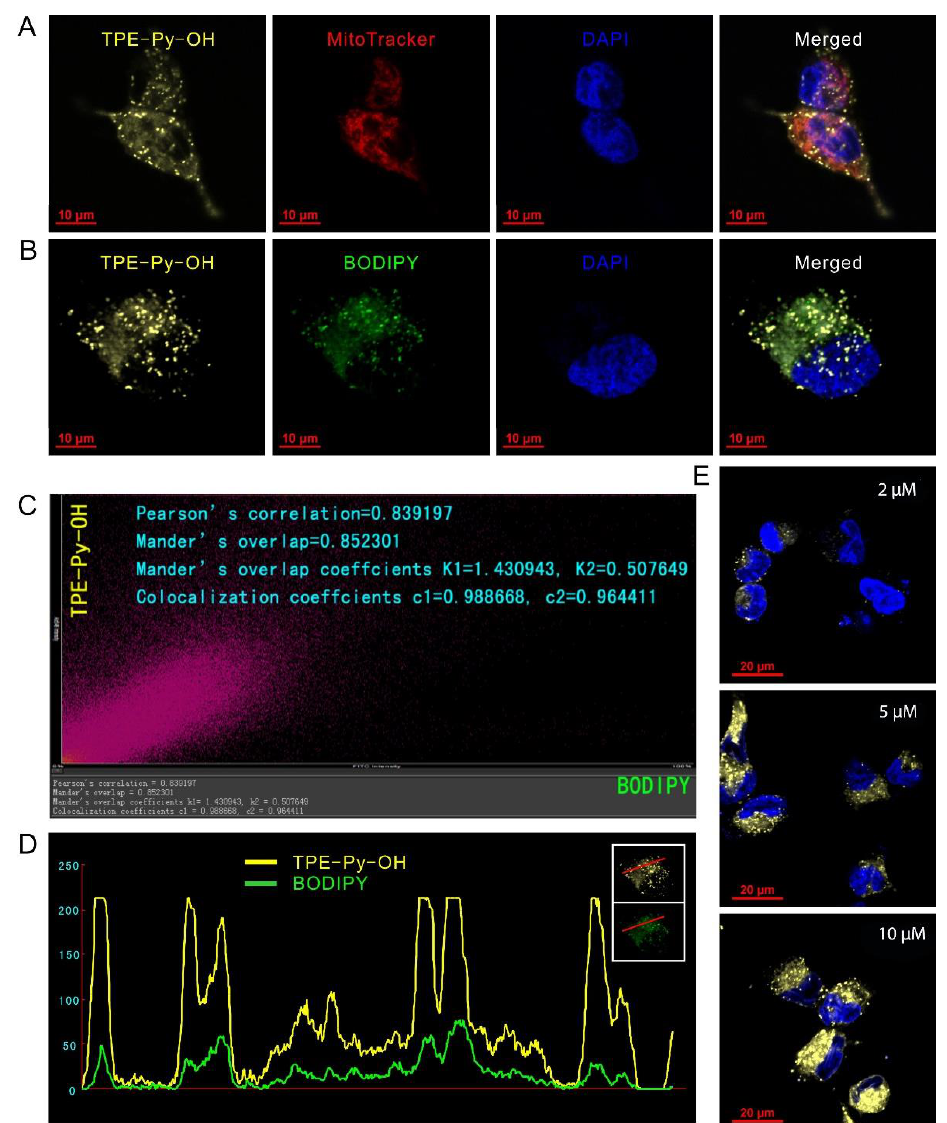
Figure 2. Fluorescence imaging of TPE-Py-OH in HepG2 cells. ( A ) Co- staining of 5 μM TPE -Py-OH (λex = 405 nm) and 50 nM MitoTracker Red (λex = 581 nm) for 30 min. ( B ) Co-staining of cells incu- bated w ith 5 μM TPE -Py-OH for 30 min, followed by continuous incubation in fresh medium for 12 h and then staining with 1 μg/L BODIPY (λex = 488 nm) for 30 min. ( C , D ) Quantitation analysis of the cells co-stained with TPE-Py-OH and BODIPY. ( E ) Images of TPE-Py-OH in HepG2 cells incu- bated at various concentrations for 30 min.